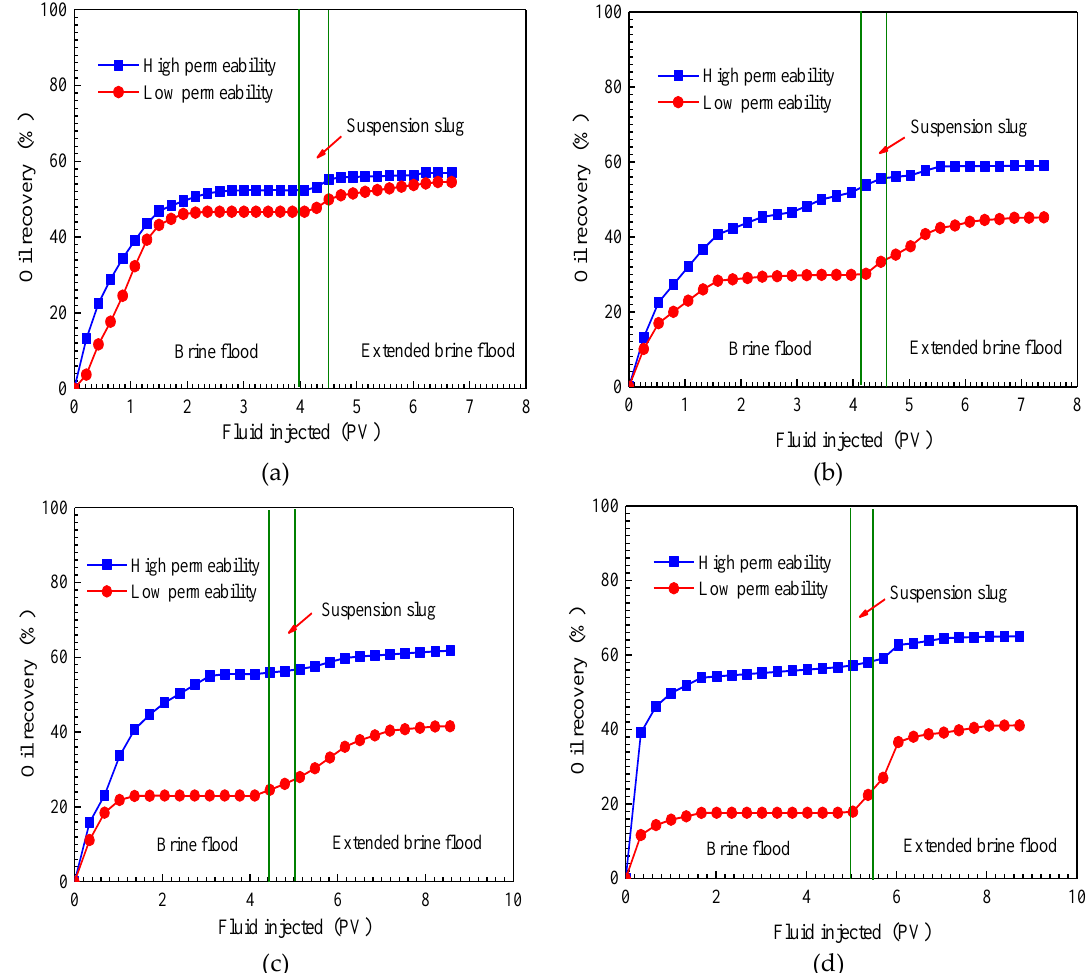
Figure 9. Cumulative oil recoveries of four parallel cores flooding tests. Permeability ratio: ( a ) 1.40; ( b ) 4.36; ( c ) 8.28; ( d ) 15.49.